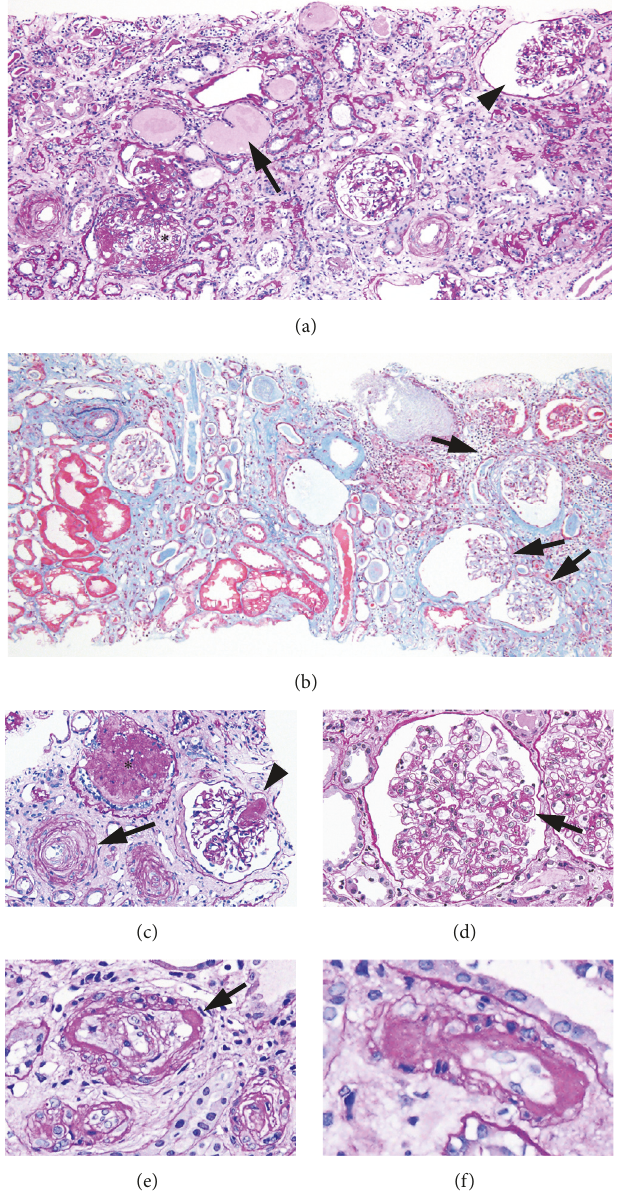
Figure 2: Light micrographs of renal tissues. (a) A glomerulus (asterisk) is mildly enlarged, showing focal segmental glomerulosclerosis while another glomerulus exhibits collapsed capillary tuft (arrowhead). Dilated tubules with flattened epithelial cells containing proteinaceous casts are present (arrow) (periodic acid-Schiff stain; original magnification x200). (b) Several glomeruli have collapsed capillary tufts (arrows). There is an extensive striped pattern of interstitial fibrosis and tubular atrophy (Elastica–Masson staining; original magnification x200). (c) A glomerulusisgloballysclerotic(asterisk).Thereisorganizedthrombusformationwithinanafferentarteriolarlumen(arrowhead).Concentric intimal hyperplasia of arterioles forming “onion skin” lesion is noted (arrow) (periodic acid-Schiff stain; original magnification x200). (d) Glomerular capillary wall is segmentally thickened showing double contour (arrow) (periodic acid-Schiff stain; original magnification x400). (e) Arteriolar lumina are occluded by fibrous intimal thickening with recanalization. Nodular hyalinosis of arterial walls is noted (arrow) (periodic acid-Schiff stain; original magnification x400). (f) An arteriolar wall shows circumferential and transmural hyalinosis forming peripheral nodules (periodic acid-Schiff stain; original magnification